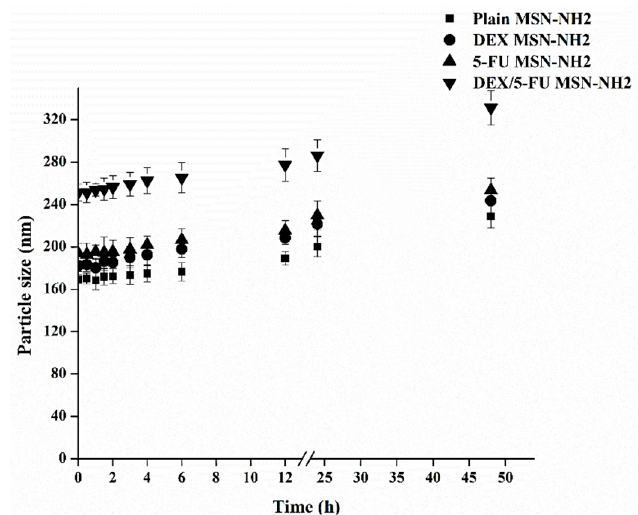
Figure 5. Particle size of free and drug loaded MSN-NH 2 measured by DLS in distilled water as a function of time.